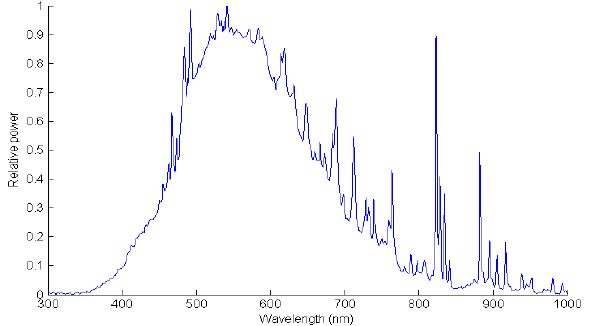
Figure 1. Spectral power distribution of studio flash